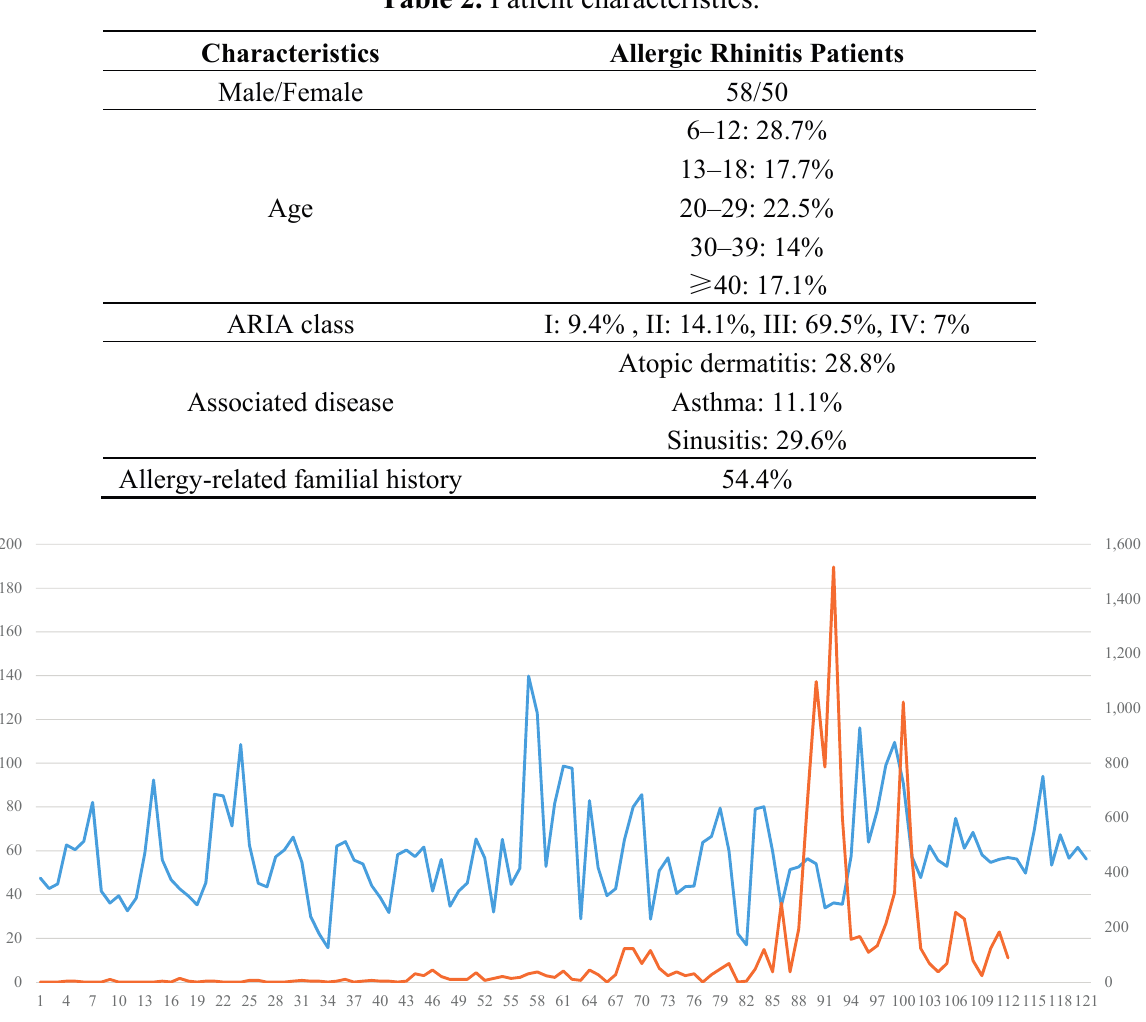
Figure 2. PM 10 and pollen dispersions. The PM 10 and pollen concentrations were measured consecutively for 120 days. PM 10 : PM 10 concentration; FLO: pollen concentration. (Lt. bar: PM 10 μ g/m 3 ; Rt bar unit: pollen particle/m 3